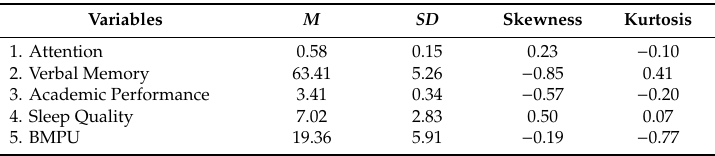
Table 1. Descriptive properties of study variables ( n = 385).